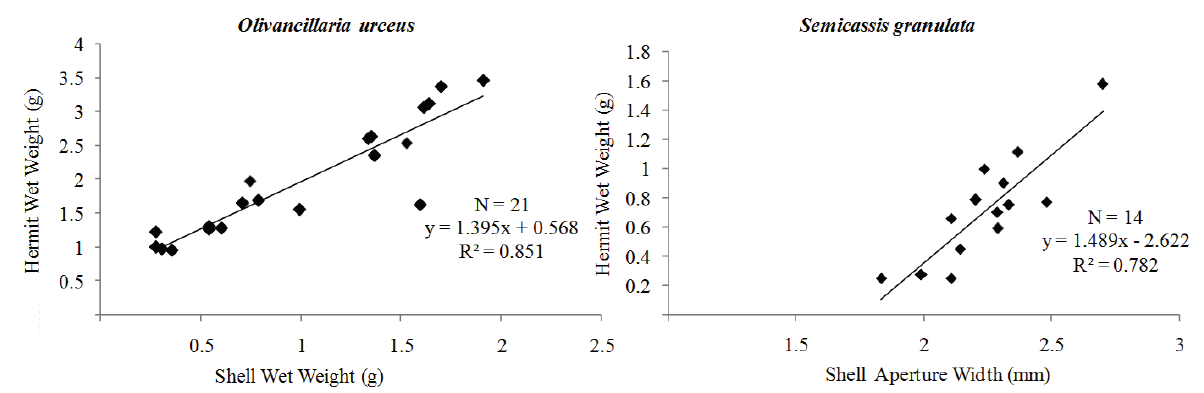
Figure 5. Loxopagurus loxochelis: Linear Regressions between Hermit Wet Weight (HWW) vs. Shell Wet Weight (SWW) of Olivancillaria urceus , and HWW vs. Shell Aperture Width (SAW) of Semicassis granulata during the study period in the area adjacent to Babitonga Bay, Santa Catarina,